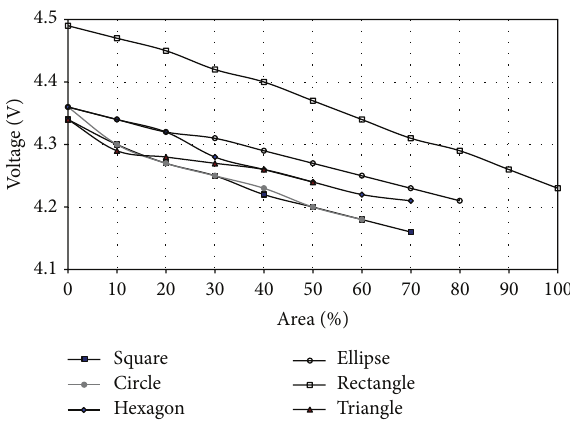
Figure 5: Comparison of voltage values obtained for semitranspar- ent areas on light source.